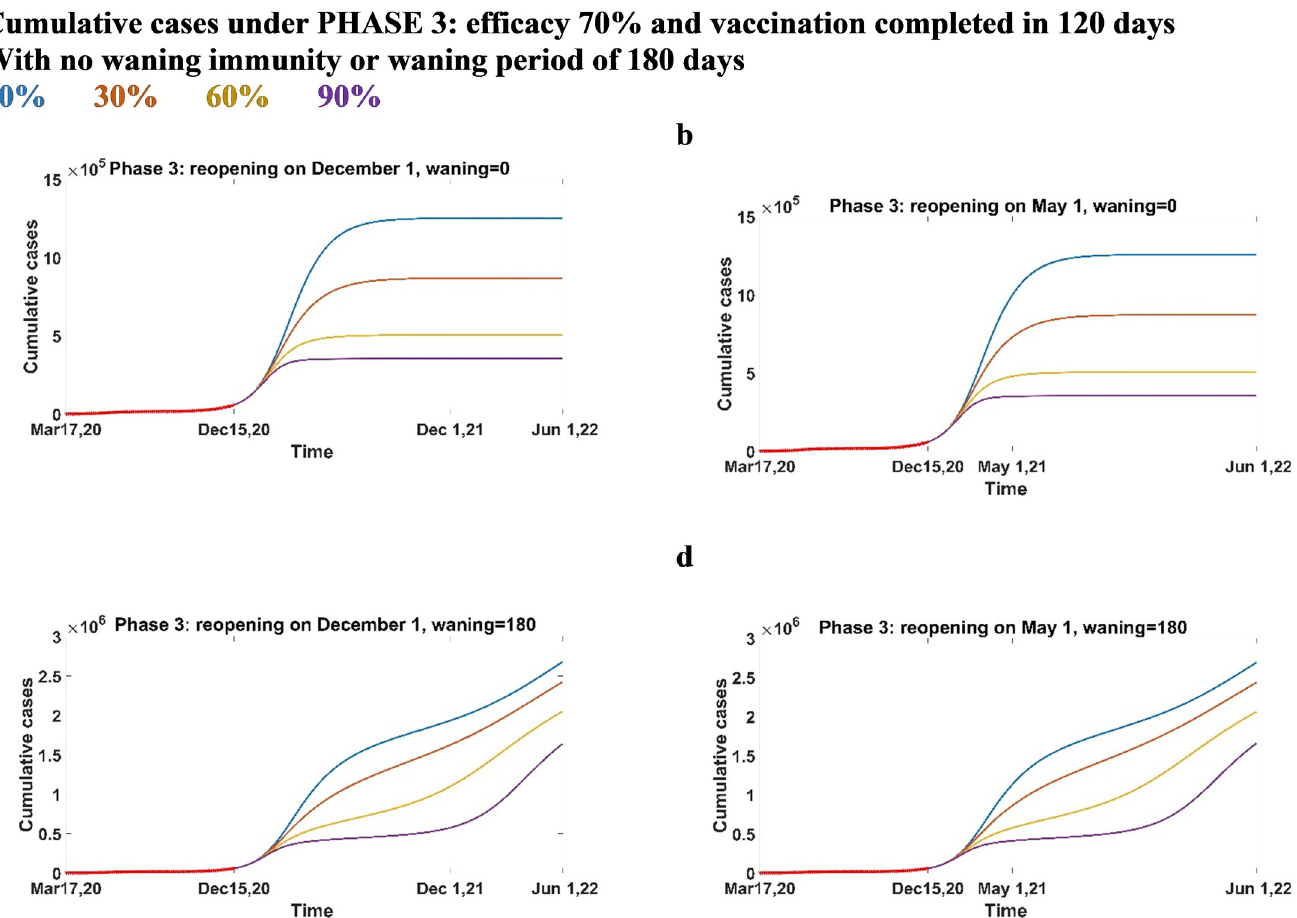
Fig 6. Cumulative cases under Phase 3: Efficacy 70% and vaccination completed in 120 days. Cumulative cases when the vaccine efficacy is 70%, vaccination is completed in 120 days under Phase 3 conditions, reopening in December 2021 (a-c) or May 2021 (b-d) and immunity does not wane (a-b) or wanes over 180 days (c-